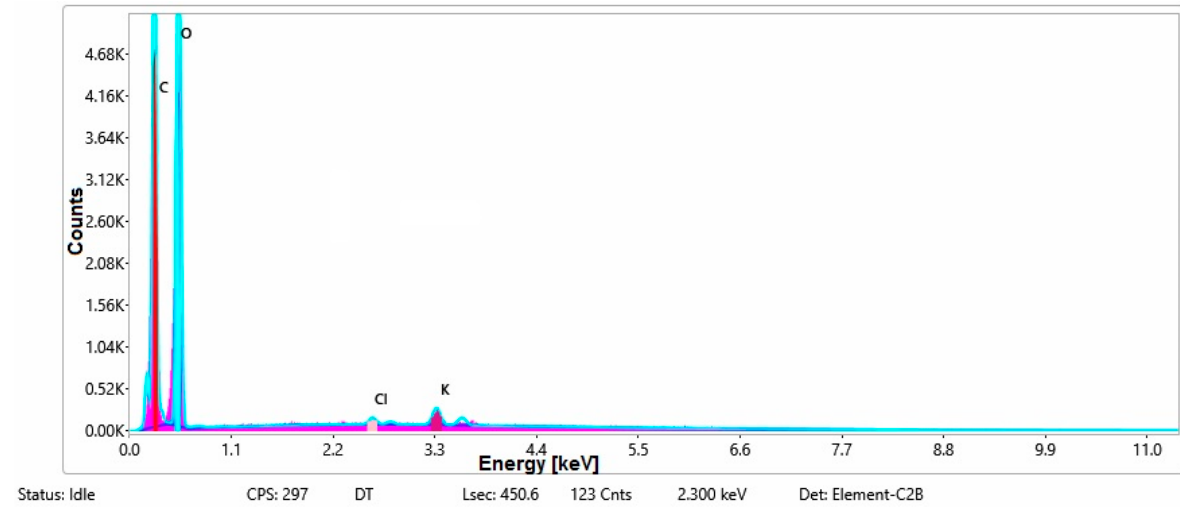
Figure 12. ESD spectra for sample S2 treated in RF plasma O 2 , using RF 1 generator and power 200 W.